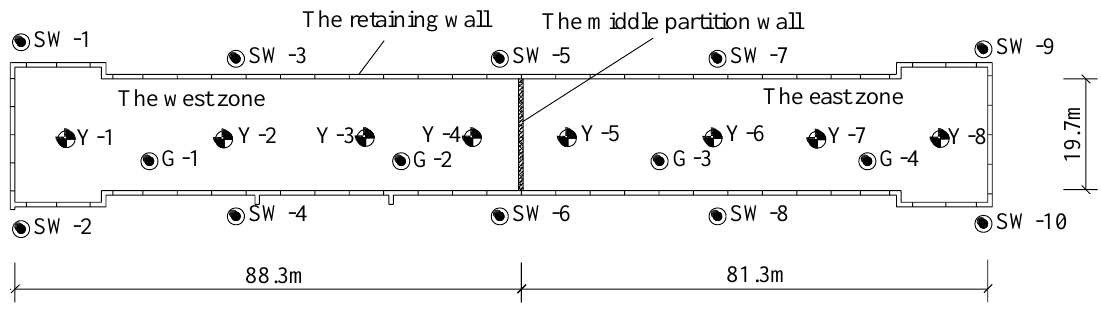
Figure 14. Location of the wells.